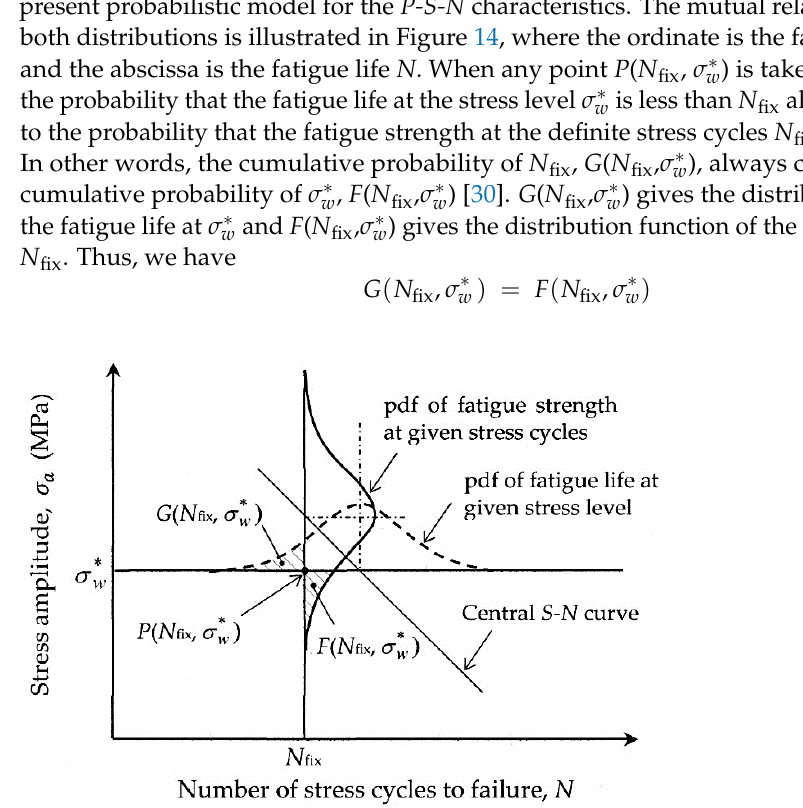
Figure 14. Relationship between fatigue strength distribution and fatigue life